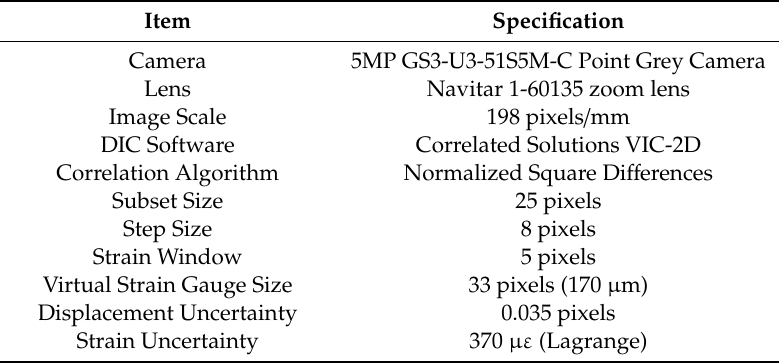
Figure 1. Specimen orientation and digital image correlation (DIC) imaging plane relative to loading direction. The DIC camera is positioned normal to the imaging plane. Table 2. DIC (Correlated Solutions Inc., Irmo, SC, USA) parameters.